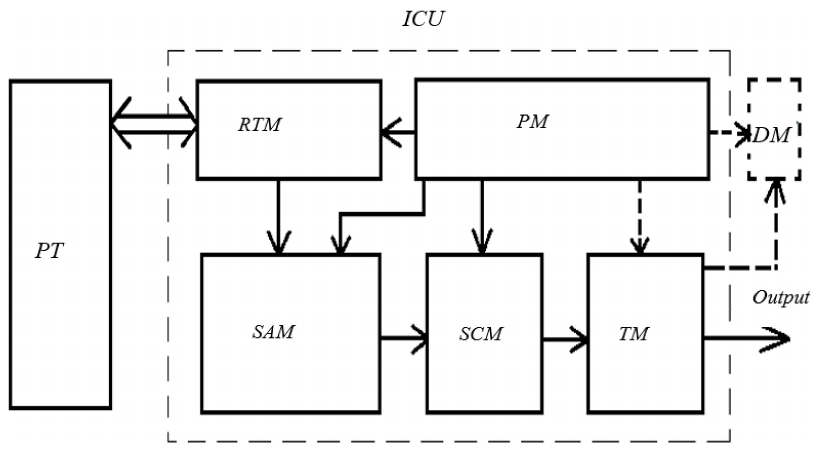
Figure 7. Block diagram of a modular block for converting information. ICU—information conversion unit; SCM—signal conversion module; PT—primary measuring transducer; TM—transmitting module (if necessary); RTM—receiving and transmitting module; PM—power module; SAM—signal amplification module; DM—display module (if